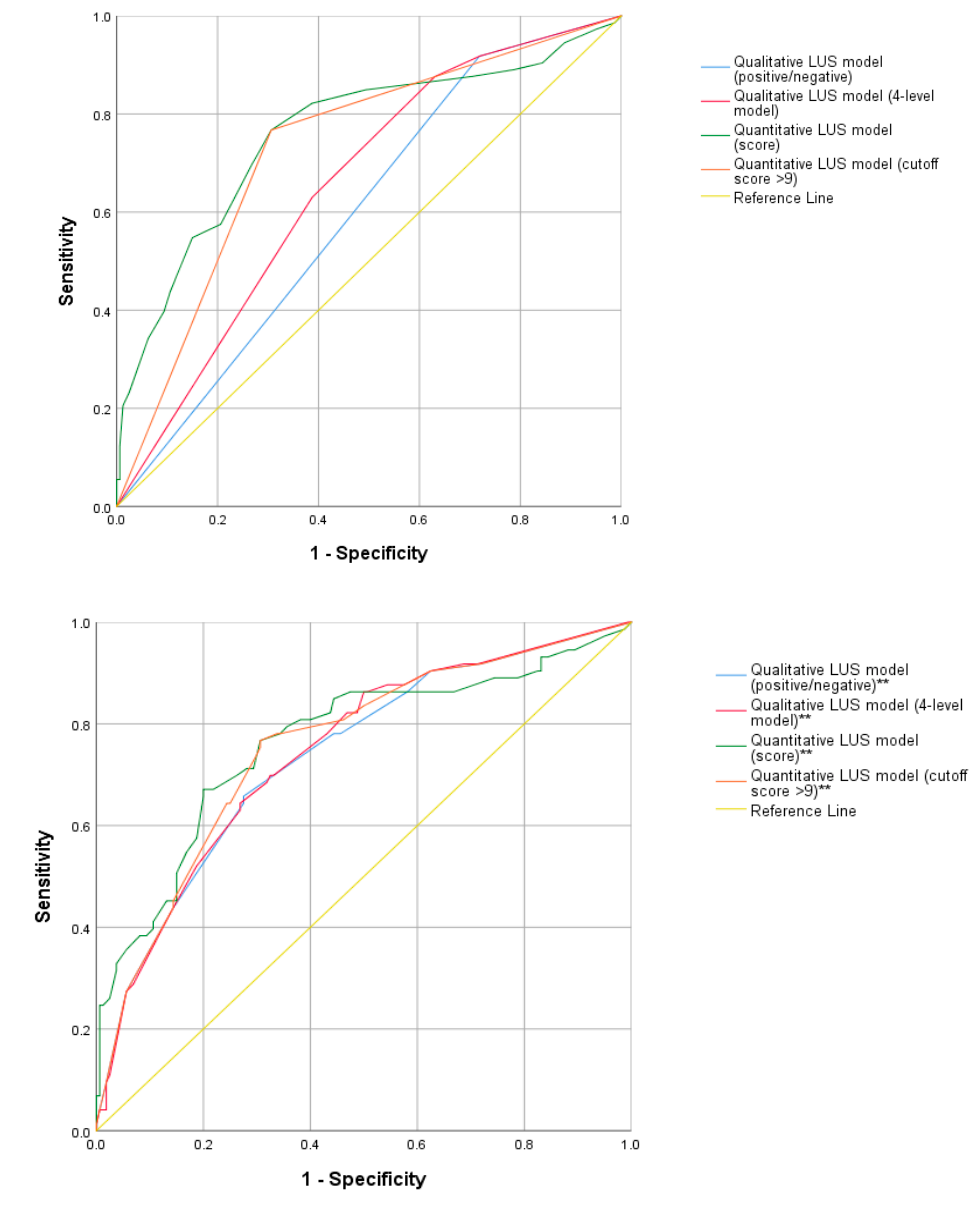
Figure 4. ROC curves comparing qualitative (positive/negative LUS, 4-level LUS including normal, interstitial, consolidative and mixed pattern) and quantitative (mean scores, cutoff score of 9) LUS models. ** ROC curves using the LUS models with the adjunction of the LUS variables “extension” and “early involvement of paravertebral areas”.